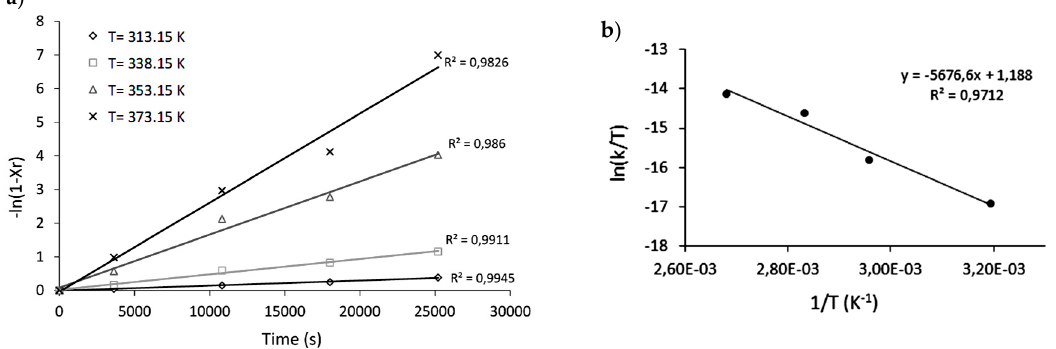
Figure 4. ( a ) Plot of − ln ( 1 − X r ) versus reaction time at the studied temperatures (see Figure 1c); ( b ) Erying plot of ln ( k / T ) vs. 1/ T for thermodynamic parameter determination.